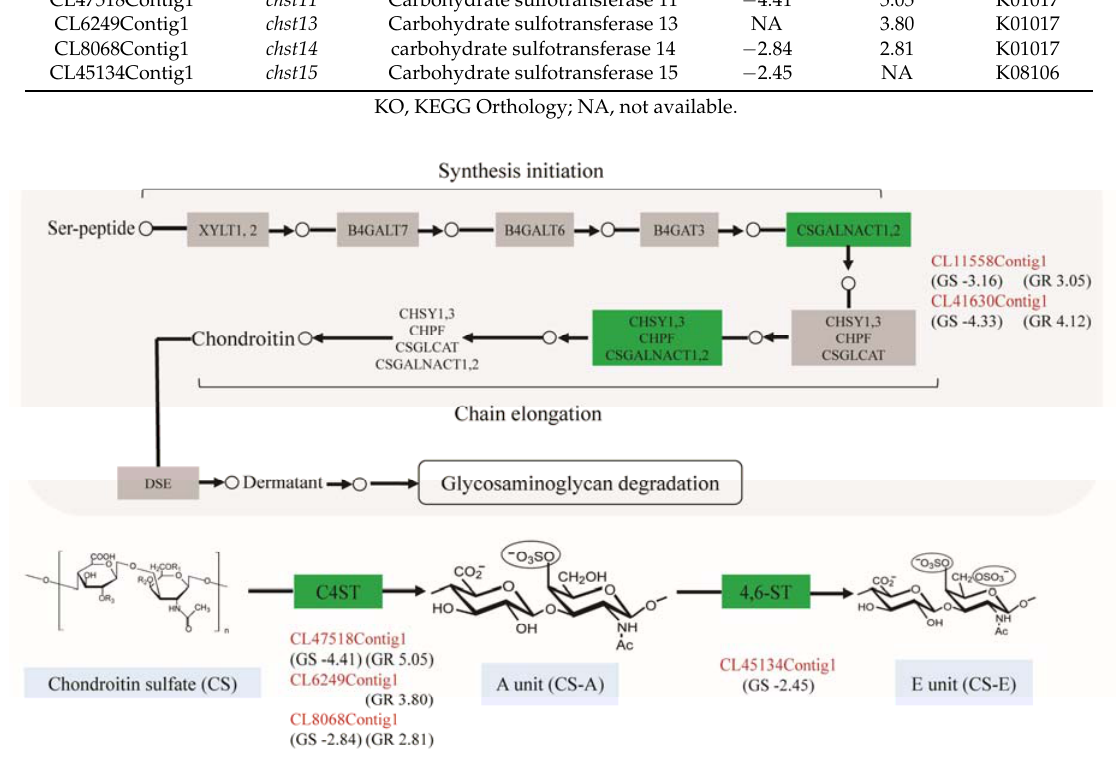
Table 3. The differentially expressed genes involved in glycosaminoglycan biosynthesis